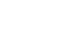
12 IMG.12: Italian Pavillion Expo 1967, Customs Section, longitudinal section, sketch on pa- per, CSR; IMG.13-14: Italian Pavillion Expo 1967, pictures of the model (picture by G. Gameliel), CSR; IMG.15: Italian Pavillion Expo 1967, Customs Section,, “stazione 4”, sketch on paper, CSR.